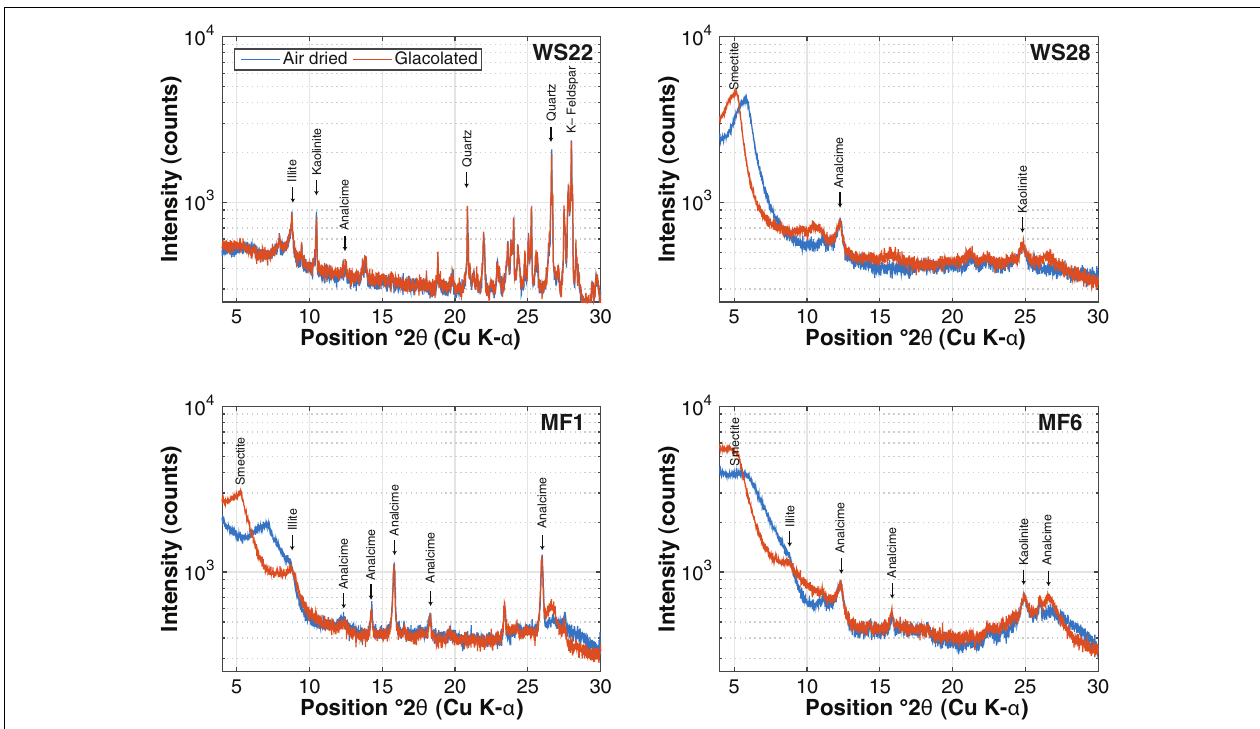
FIGURE 4 | XRD patterns of preferred-oriented, air-dried and glycolated mounts of the < 2 µ m size-fraction for four (4) WS and MF samples of modern Chew Bahir sediments. WS, modern watershed; and MF, modern mudflat. XRD patterns for air-dried samples are shown in blue, and those for samples treated with ethylene glycol, red.